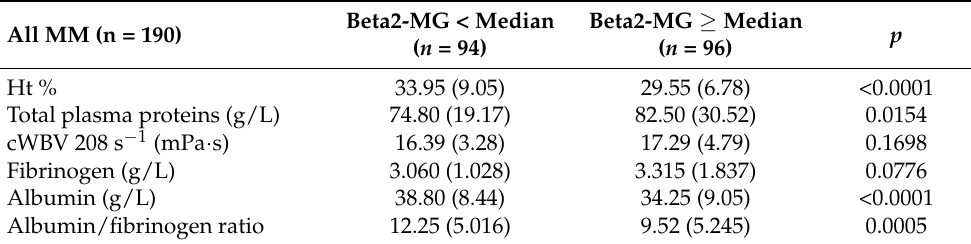
Table 6. Medians (IQR) of hemorheological determinants in all MM patients subdivided according to the median of beta2-MG.